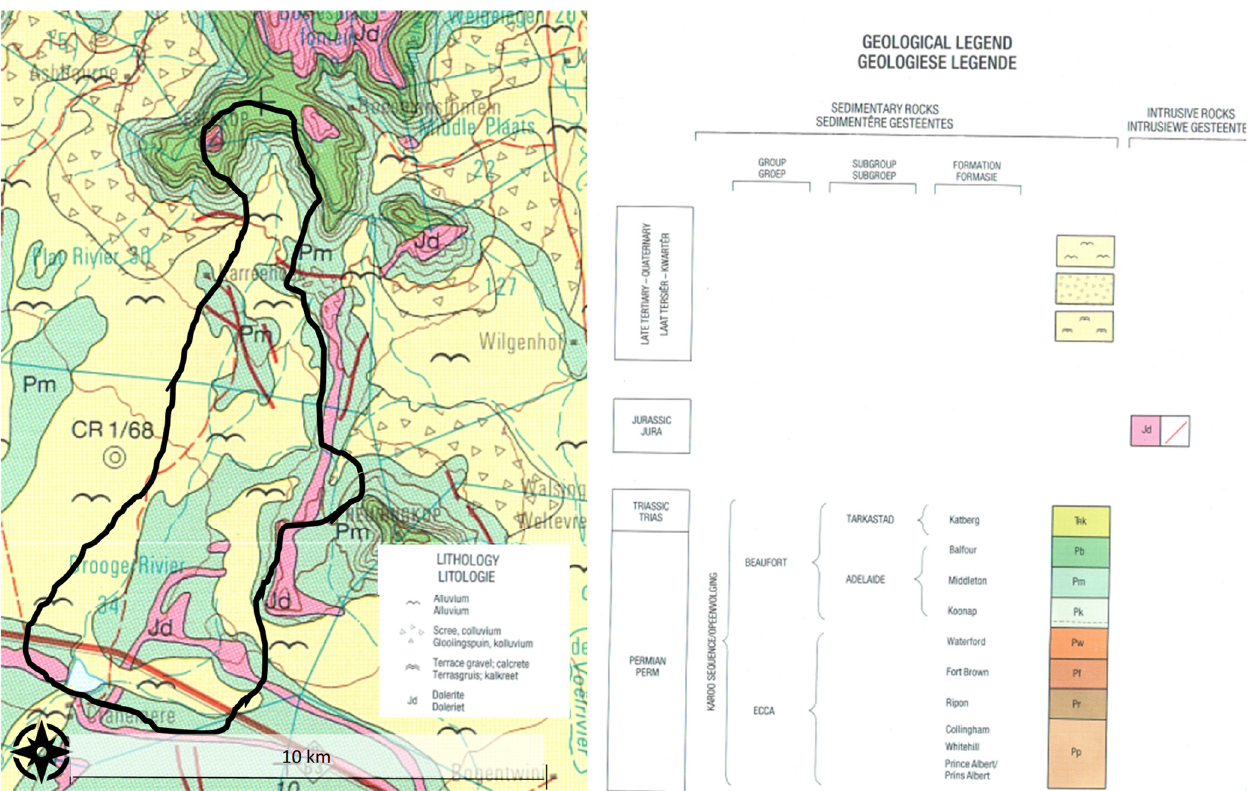
Figure 4. Cranemere dam catchment geological features, indicating the presence of alluvium and dolerite dykes.